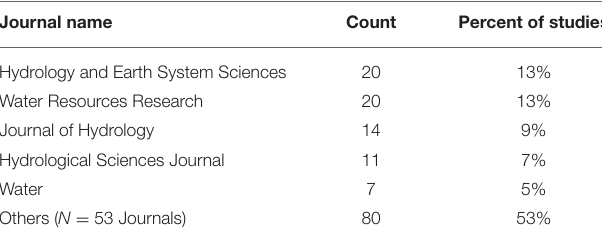
TABLE 6 | Results by journal for the top 5 journals with the most primary